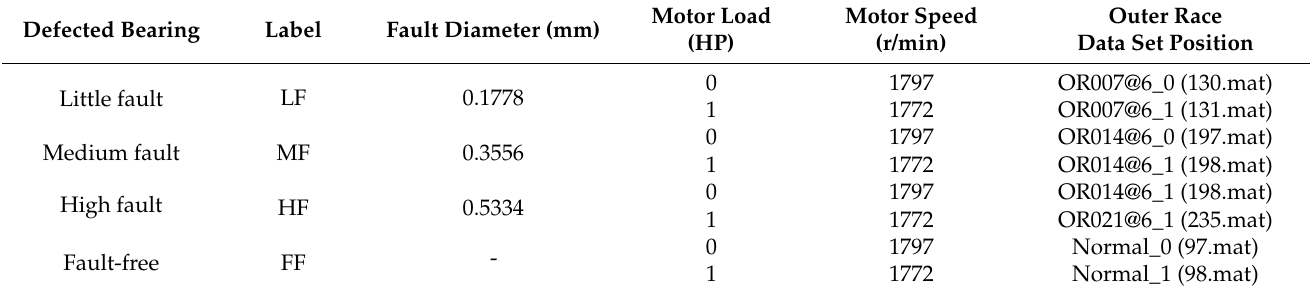
Table 6. Details of the Case Western Reserve University defective bearing dataset.